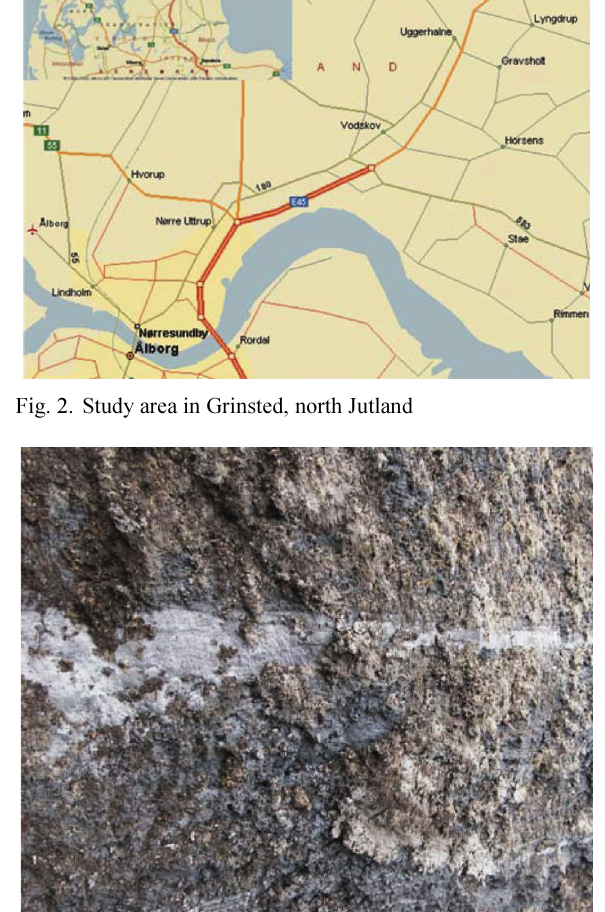
Table 2. Data obtained from vane shear tests (Ibsen, Barari